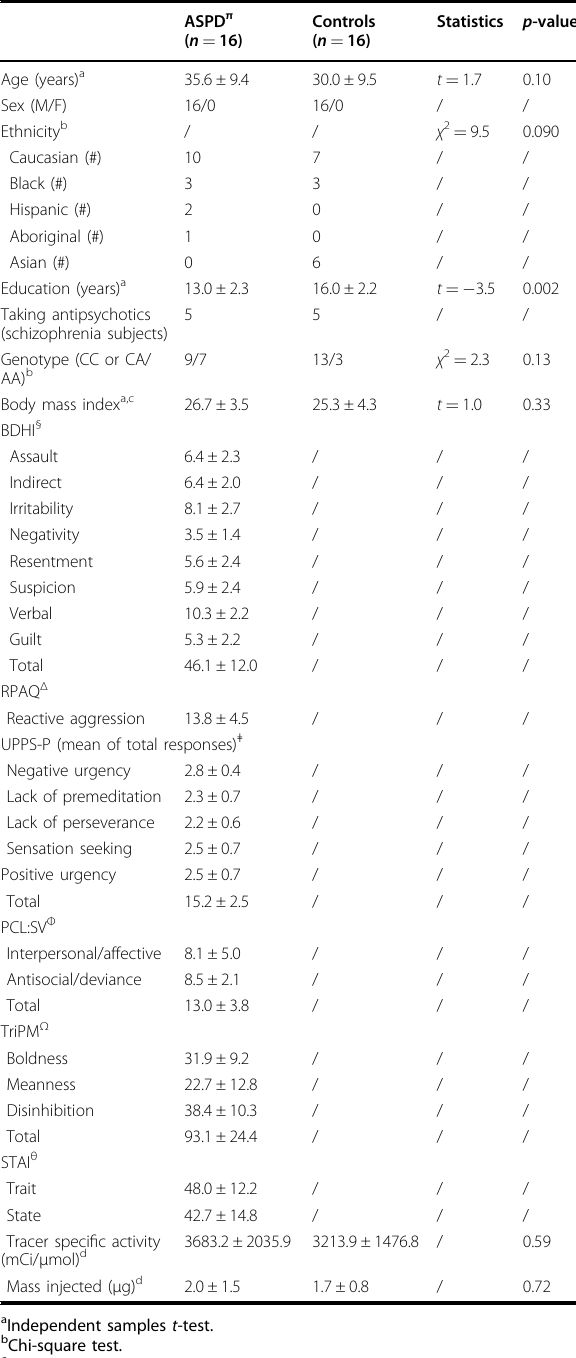
Table 1 Clinical and demographic